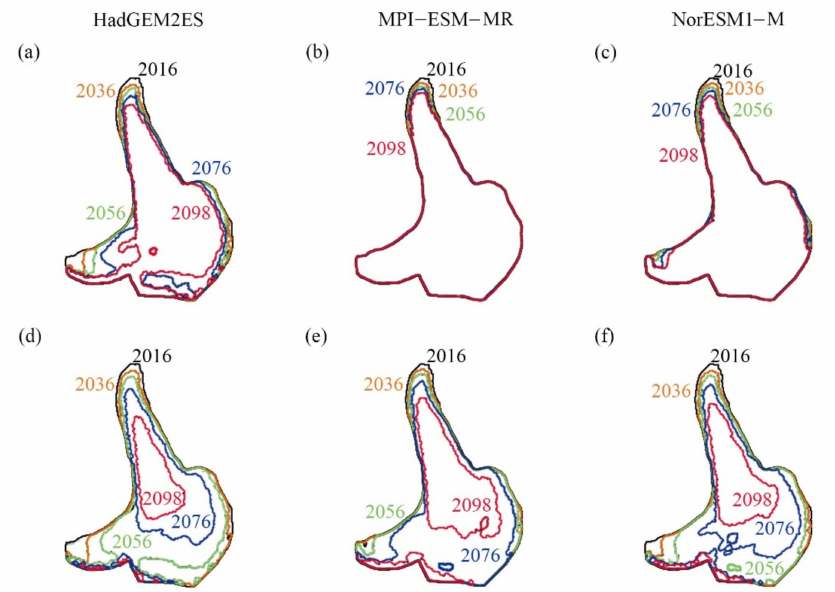
Figure 15. Modeled terminus retreat from 2016 to 2098 under RCP2.6 (upper row, plot ( a – c )) and RCP 8.5 scenarios (lower row, plot ( d – f )) using projected results from RegCM4 driven by 3 ESMs, HadGEM2ES (plot ( a , d )), MPI − ESM − MR (plot ( b , e )), NorESM1 − M (plot ( c , f